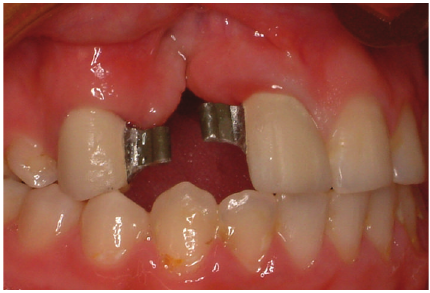
Figure 1: Case1 with cleft lip and palate.